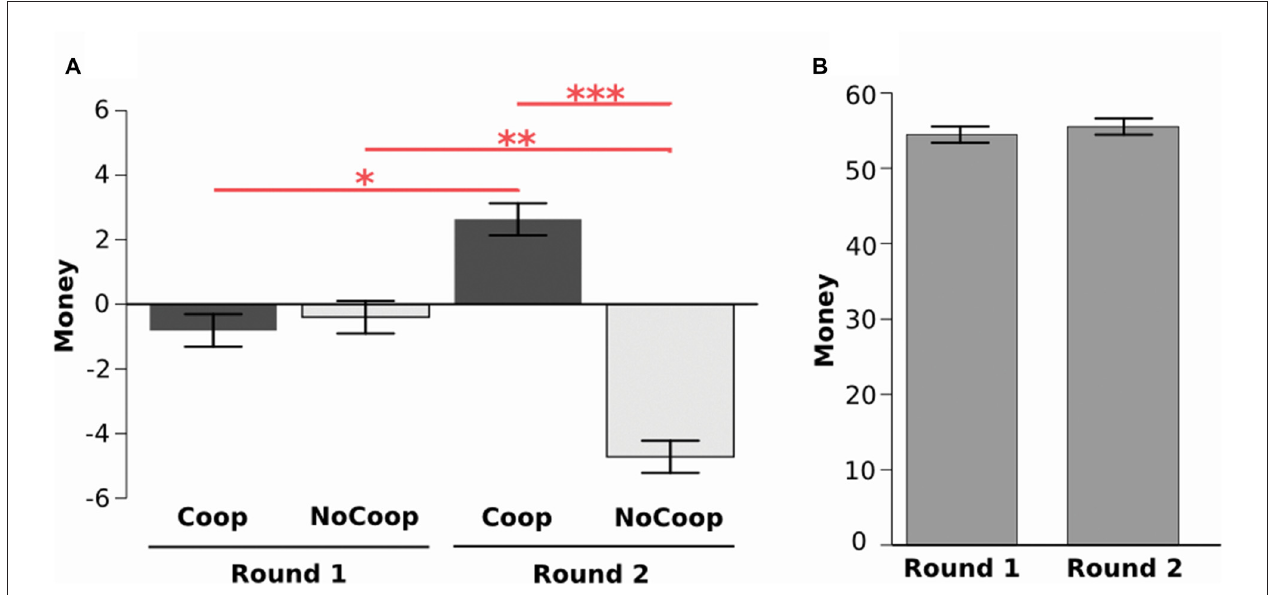
FIGURE 3 | Results of Dictator game. (A) Distribution of money during two rounds for each confederate: cooperative (Coop) and non-cooperative (NoCoop). (B) Earnings in each of the two rounds. Bars represent the mean, and the error bars show the standard error. ∗ p < 0.05, ∗∗ p < 0.01, ∗∗∗ p < 0.001.